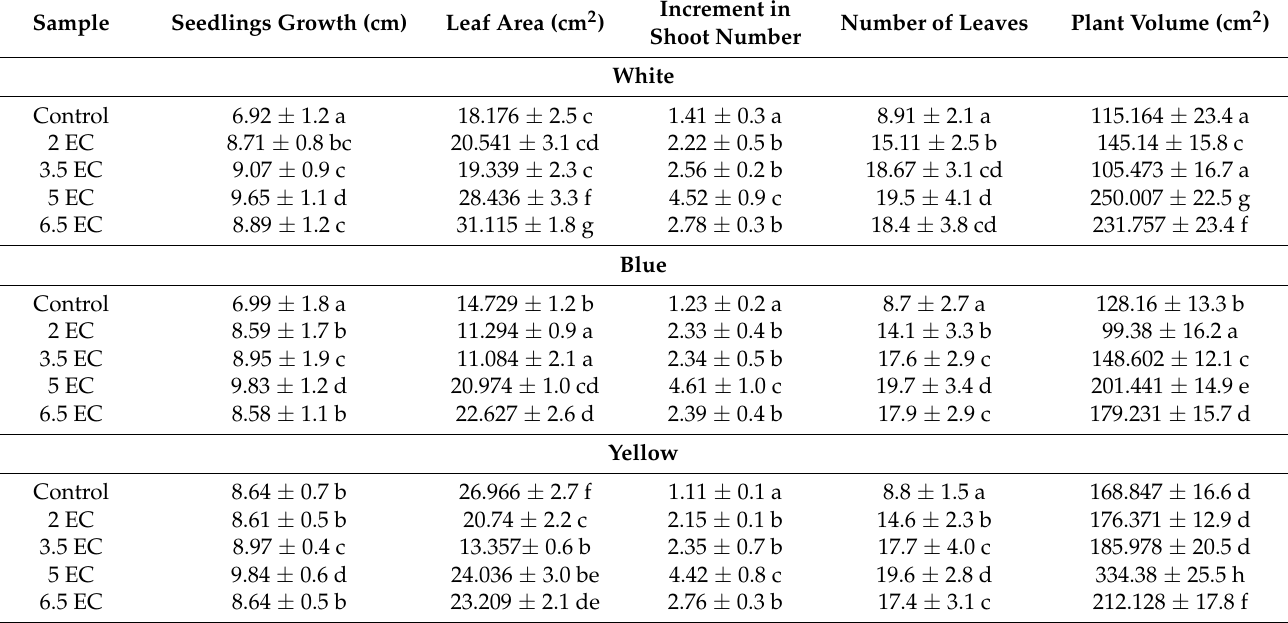
Table 1. Effect of nutrient solution electrical conductivity levels on the development of selected Viola × wittrockiana